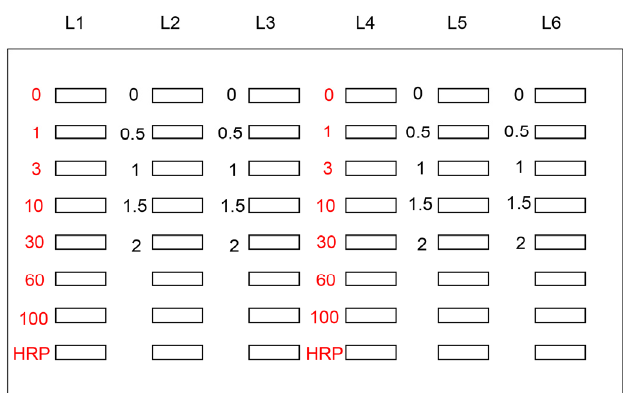
Figure 2. Setup used for the application of standard TAGE-BSA, HRP marker solution, and sample solution onto the PVDF membrane [27]. White open squares indicate the slot lane. L1, L4: 0, 1, 3, 10, 30, 60, and 100 ng of TAGE-BSA aliquots and HRP marker solution. L2, L3, L5, L6: cell lysate samples